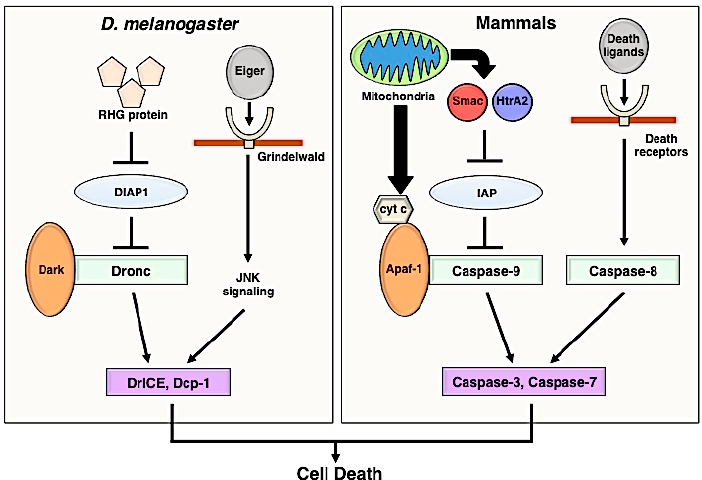
Figure 1. Schematic illustration of the apoptosis signaling pathway in Drosophila and mammals. The same colors and shapes represent functional homologous in both Drosophila melanogaster and mammals. In Drosophila , RHG proteins (Rpr, Hid, and Grim) produced by apoptotic stimuli inhibit the function of DIAP1 ( Drosophila inhibitor of apoptosis protein 1). Dark ( apaf-1 homologue) forms a complex (apoptosome) with the initiator caspase Dronc. Effector caspases DrICE and Dcp-1 are activated by the apoptosome, and the activated effector caspases promote cell death. Eiger ( Drosophila TNF α ortholog) induces the JNK (c-Jun N-terminal kinase)-mediated cell-death pathway through Grindelwald (TNF receptor). In mammals, Smac and HtrA2 released from mitochondria block